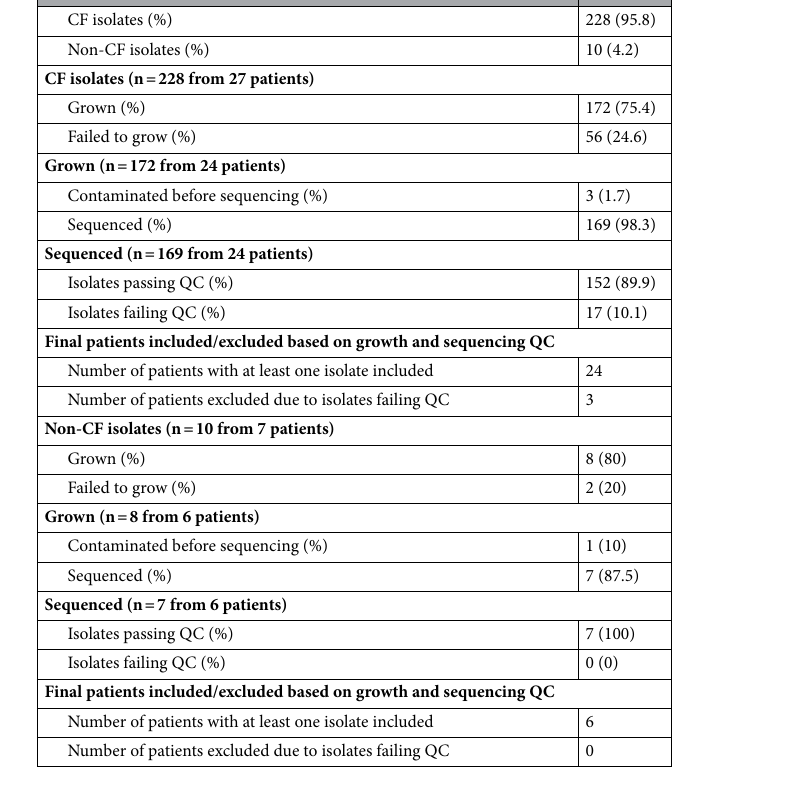
Table 2. Isolates included and corresponding patient